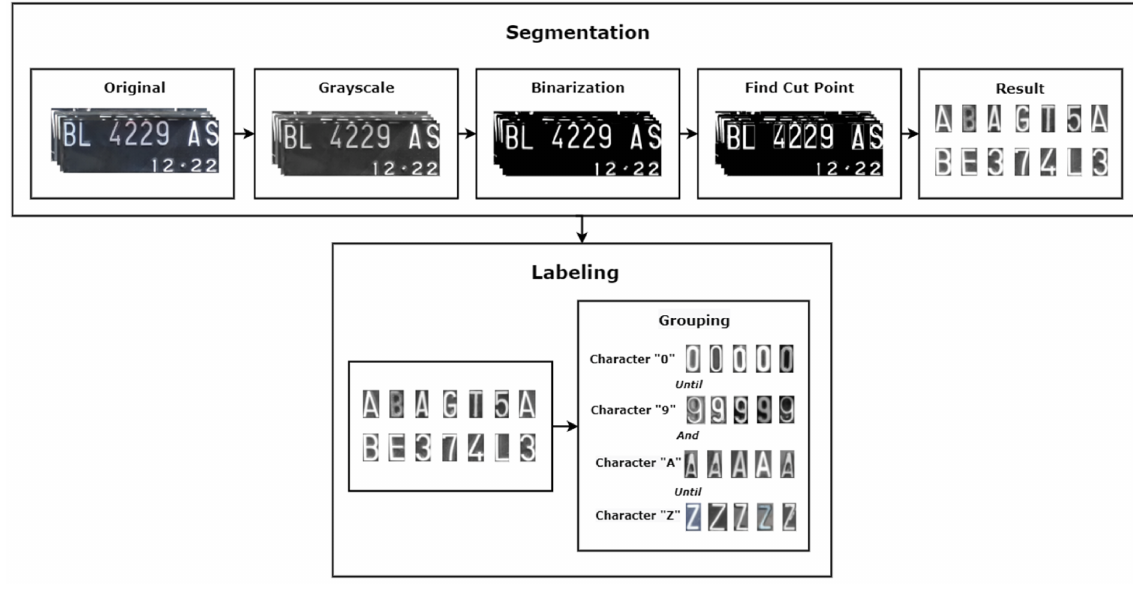
Fig. 2. The segmentation and labelling